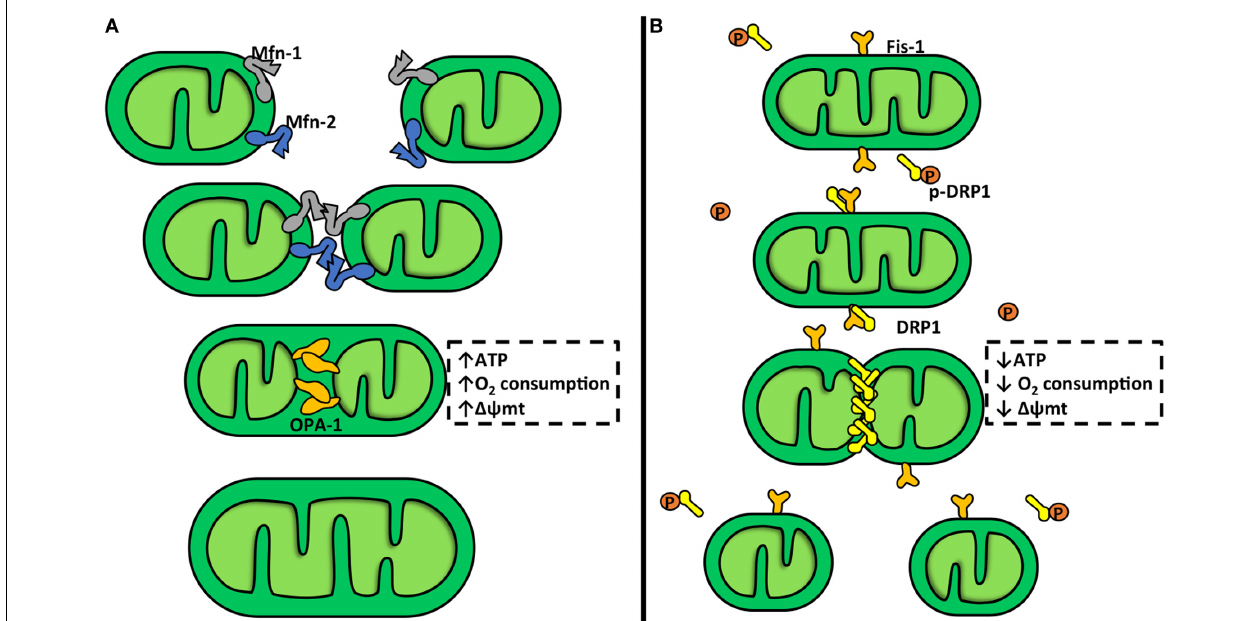
FIGURE 1 | Mitochondrial dynamics. (A) Mitochondrial fusion. This is a two-step process which involves three different proteins: mitofusin-1 and 2 (Mfn-1 and Mfn-2) and optic atrophy protein-1 (OPA-1). Mfn-1 and Mfn-2 are transmembrane GTPases embedded in the outer mitochondrial membrane (OMM). The C-terminal coiled-coil region of Mfn-1 and Mfn-2 mediates tethering between mitochondria through homo- or heterotypic complexes formed between adjacent mitochondria. This interaction mediates OMM fusion. OPA-1 is a dynamin-related protein localized in the inner mitochondrial membrane (IMM), facing the intermembrane space. OPA-1 participates in the attachment and